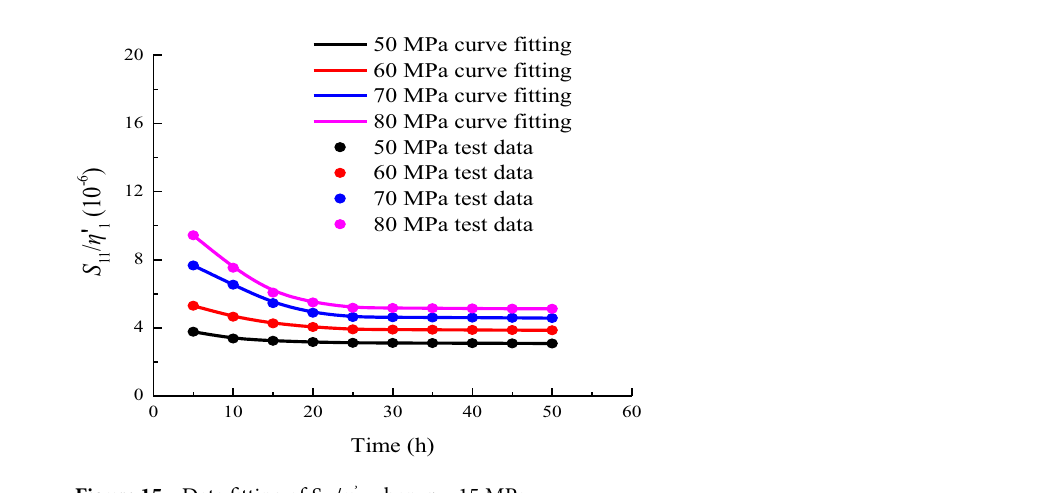
Figure 15. Data fitting of S 11 / η ’ 1 when σ 3 = 15 MPa.